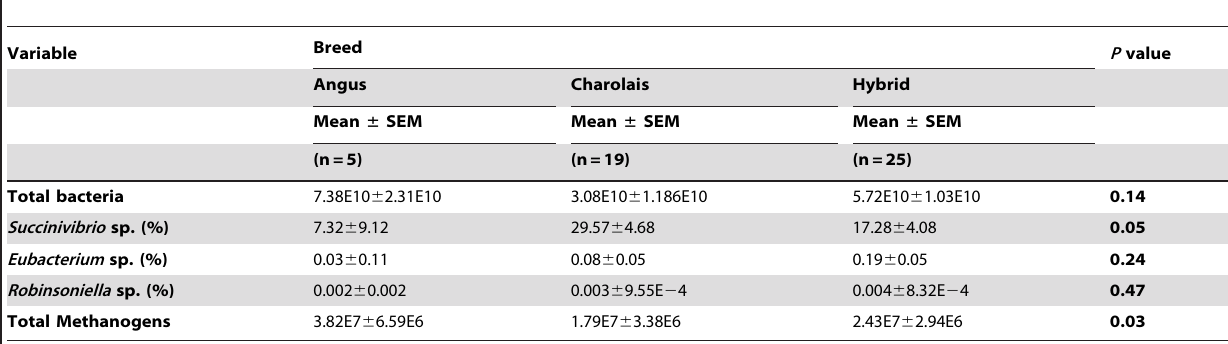
Table 6. Particular bacterial species and methanogen population in steers differing breed (n=49) in LE.